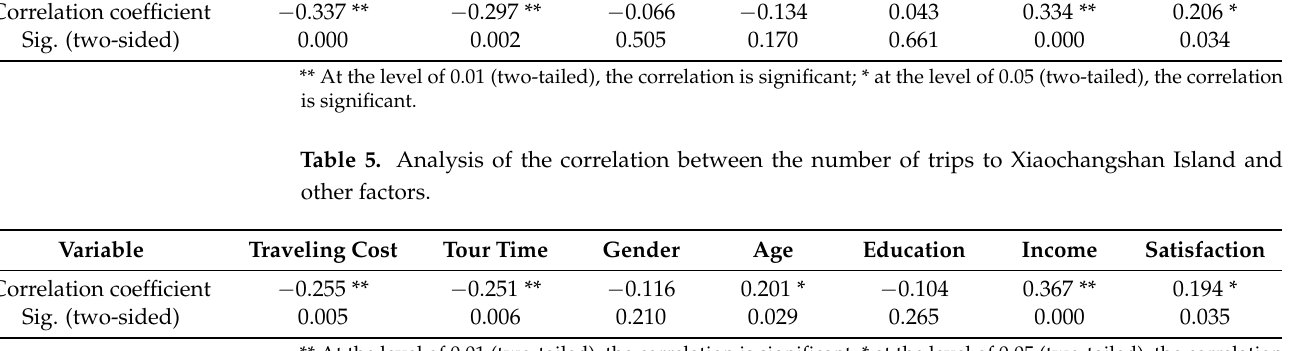
Table 5. Analysis of the correlation between the number of trips to Xiaochangshan Island and other factors.